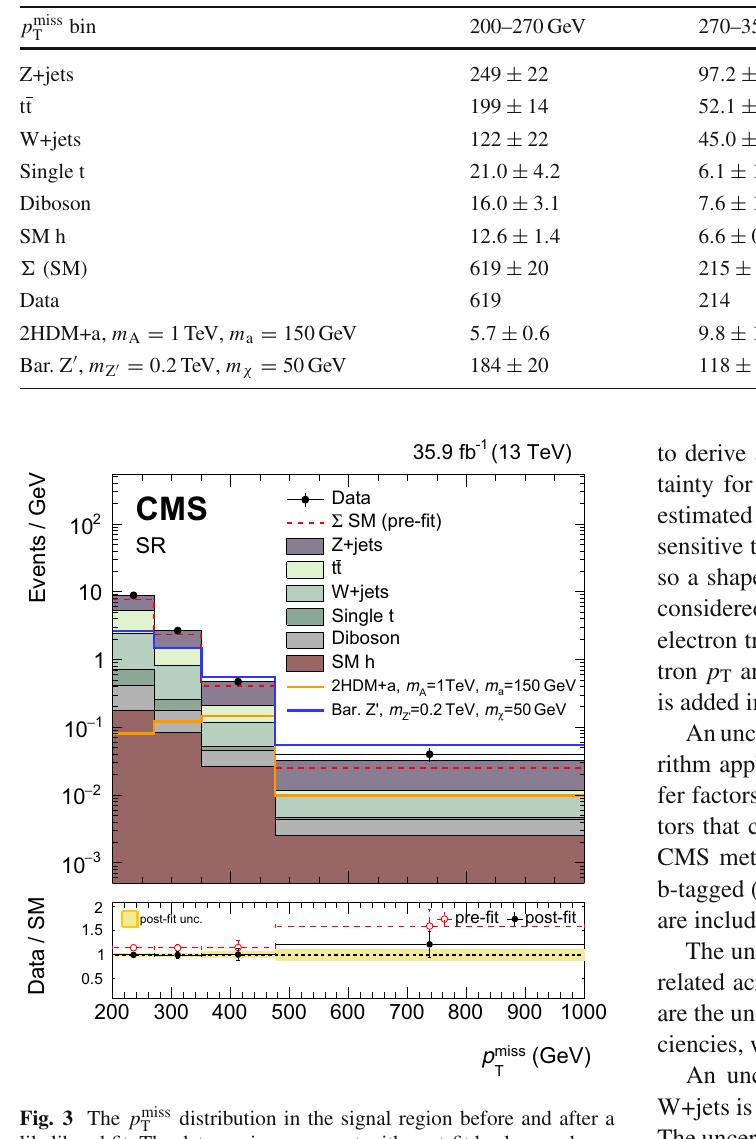
Table3 Post-fiteventyieldexpectationsper p miss binfortheSMback- are the expected yields for two signal models. Uncertainties quoted in T grounds in the signal region when including the signal region data in the predictions include both the systematic and statistical components the likelihood fit, under the background-only assumption. Also quoted